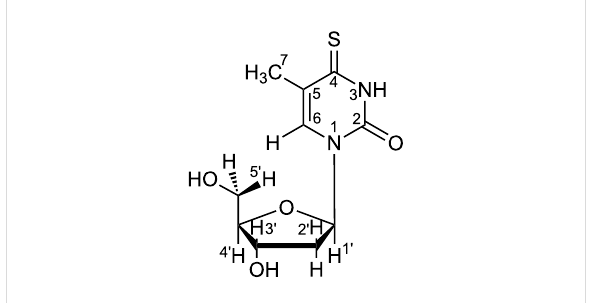
Figure 1: Molecular structure of S 4 TdR. H atoms are also labeled in the Figure.